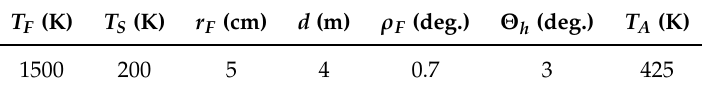
Table 4. Antenna noise